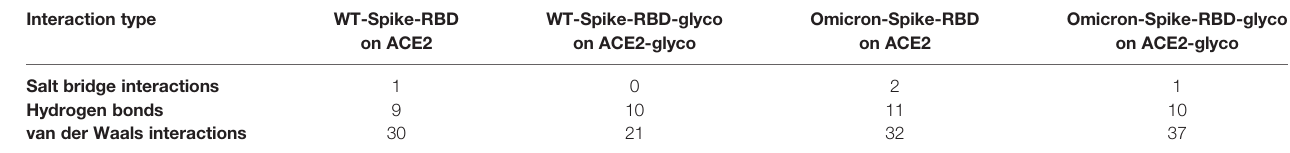
WT, wild type; RBD, receptor-binding domain. The “ GetContacts ” tool was exploited in order to calculate all the contacts between Spike and ACE2 in each of the scenarios